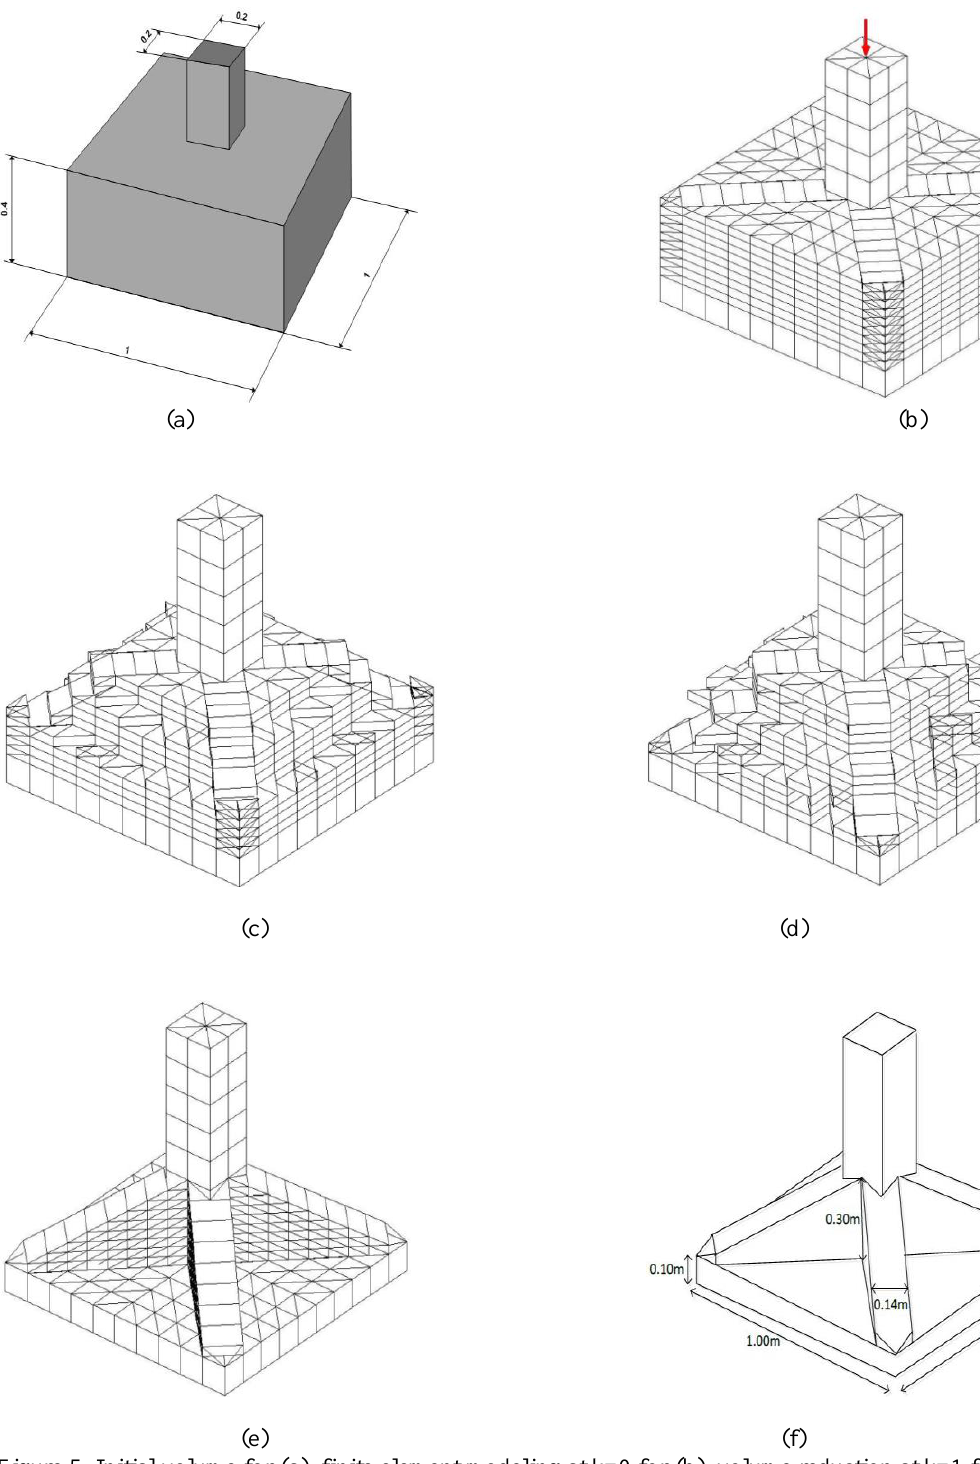
Figure 5. Initial volume for (a), finite element modeling at k=0 for (b), volume reduction at k=1 for (c) and at k=2 for (d), final form made up of four foothills at k=3 for (e) and dimensions of the final form for